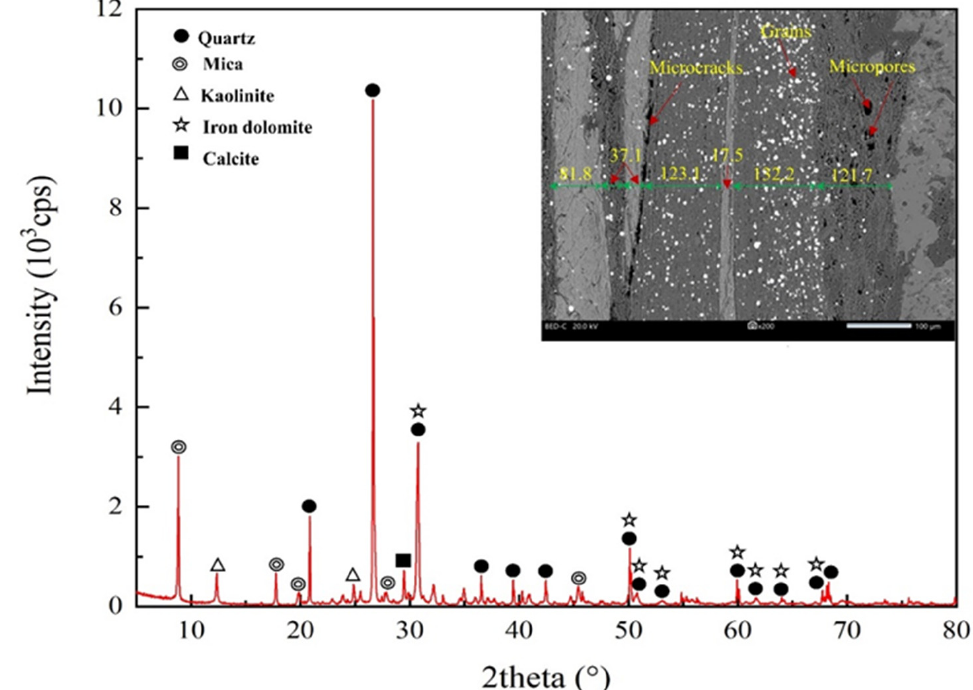
Figure 1. X-ray diffraction (XRD) and Standard Electronic Modules (SEM) analysis. Table 1. Basic physical properties of phyllite with different foliation